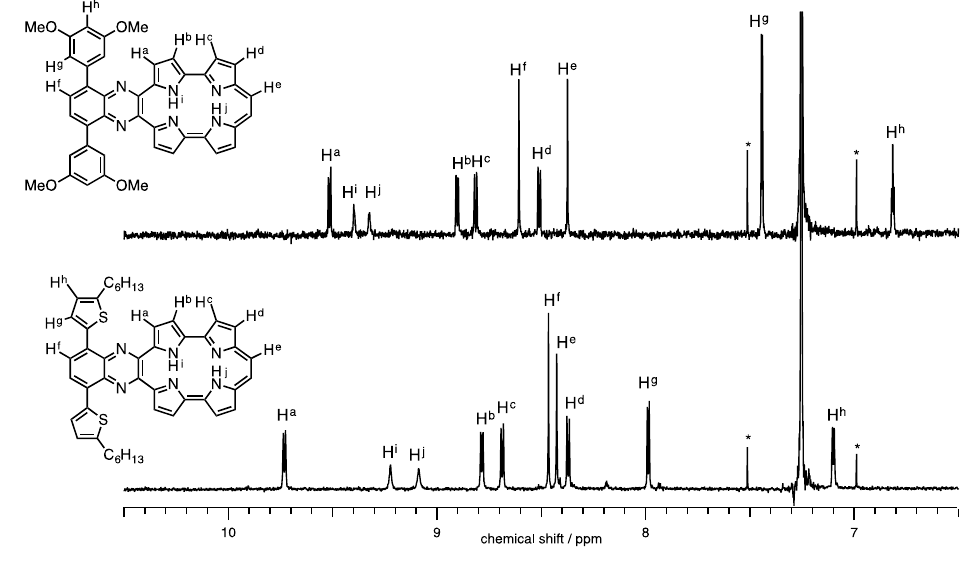
Figure 3. 1 H-NMR spectra of 1a-H 2 and 1b-H 2 in CDCl 3 .